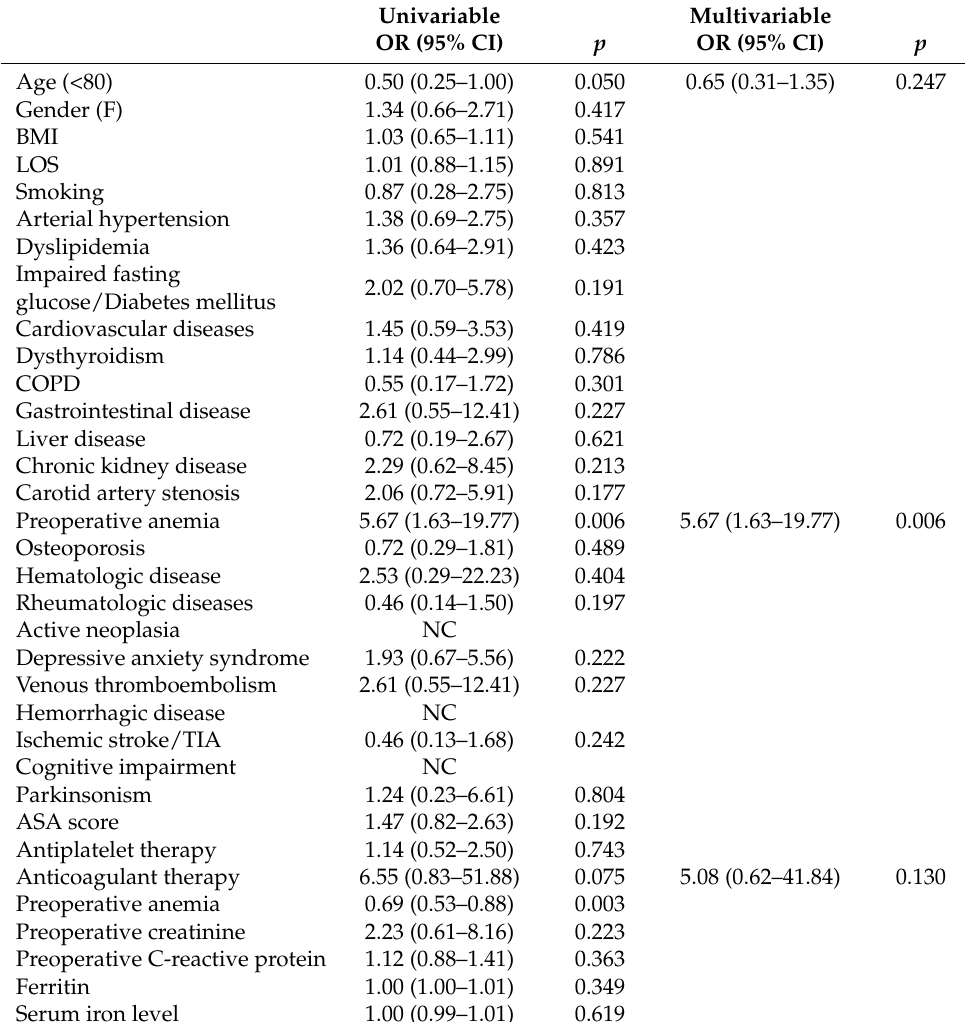
BMI, body mass index; LOS, length of stay; COPD, chronic obstructive pulmonary disease; TIA, transient ischemic attack; ASA, American Society of